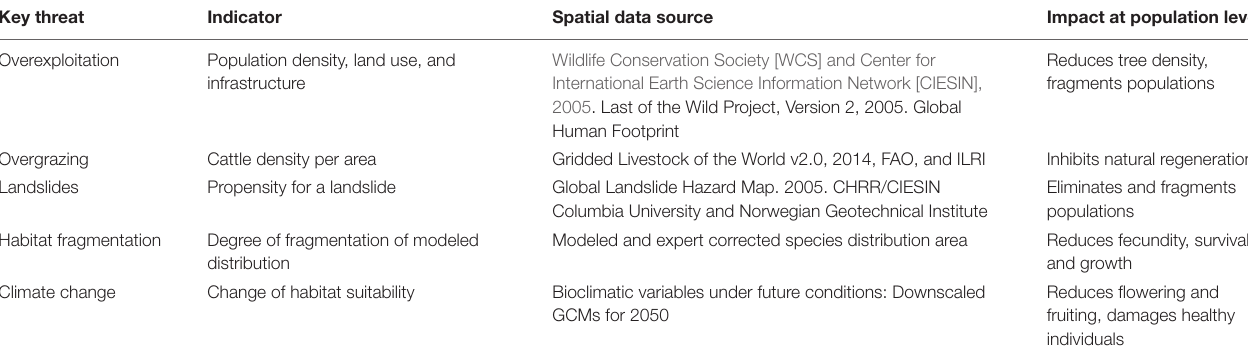
TABLE 2 | Threat layers and corresponding data